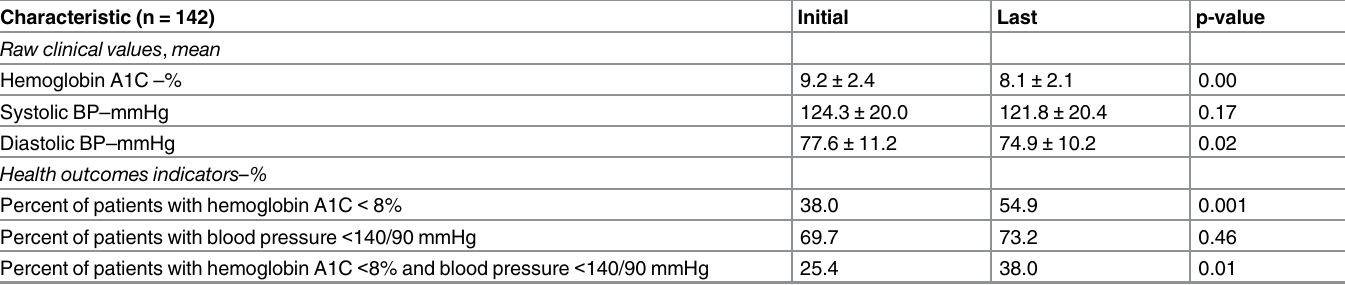
Table 5. Longitudinal outcomes indicators for Type 2 Diabetes